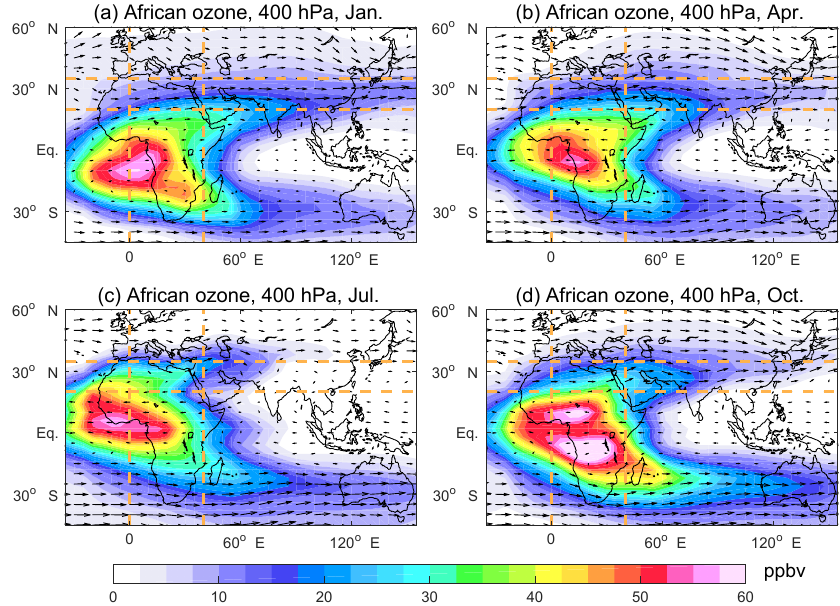
Figure 10. Horizontal distributions of African ozone (in ppbv, in color), overlaid with winds (shown by arrows), at 400hPa in (a) January, (b) April, (c) July, and (d) October. The ozone values are the means from the 20-year GEOS-Chem simulation. Between the two pairs of parallel dashed lines, latitudinal and longitudinal means are taken and shown in Figs. 11 and 12, respectively.